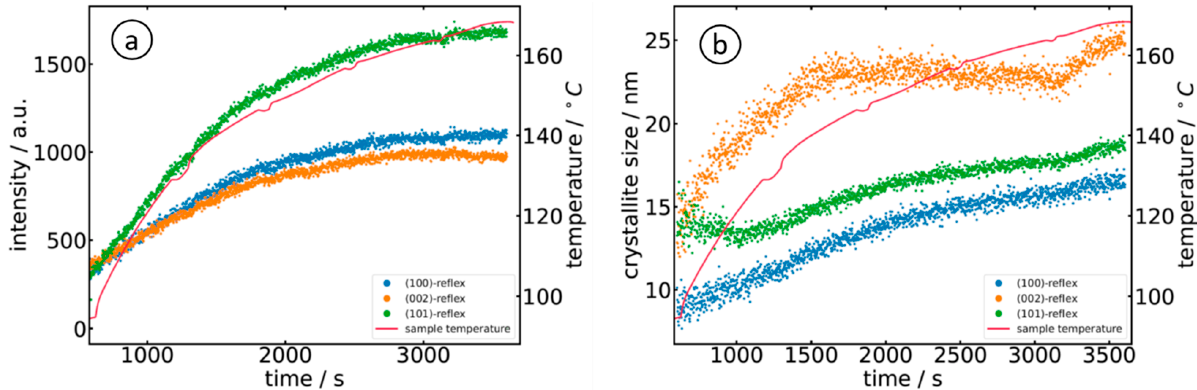
Figure 9. Evaluation of the diffractograms collected during the reaction of Zn(acac) 2 in the 1-octonal (sample O) as a function of time and temperature: ( a ) temporal evolution of the diffraction peak intensities and ( b ) evolution of the crystallite size as calculated by the Scherrer equation.